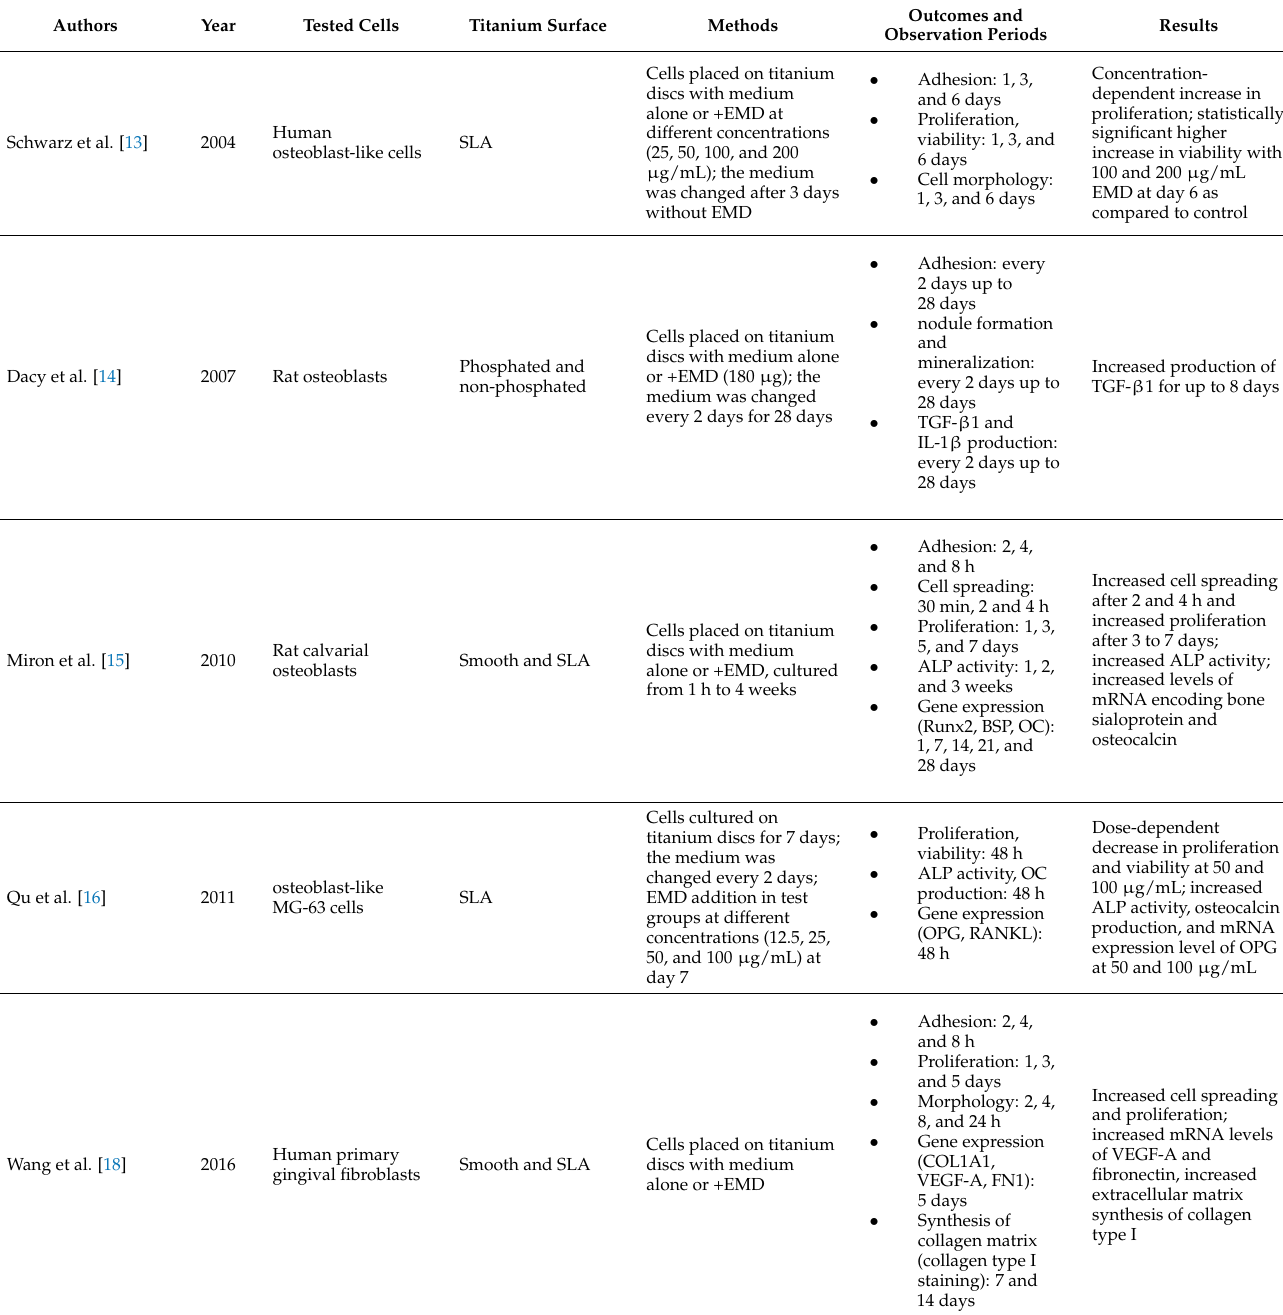
Table 1. In vitro studies that observed the behavior of EMD on titanium